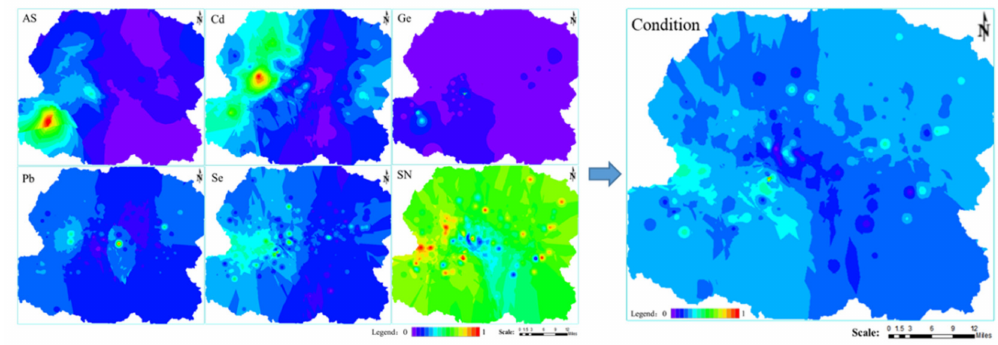
Figure 4. Spatial distribution map of Condition.